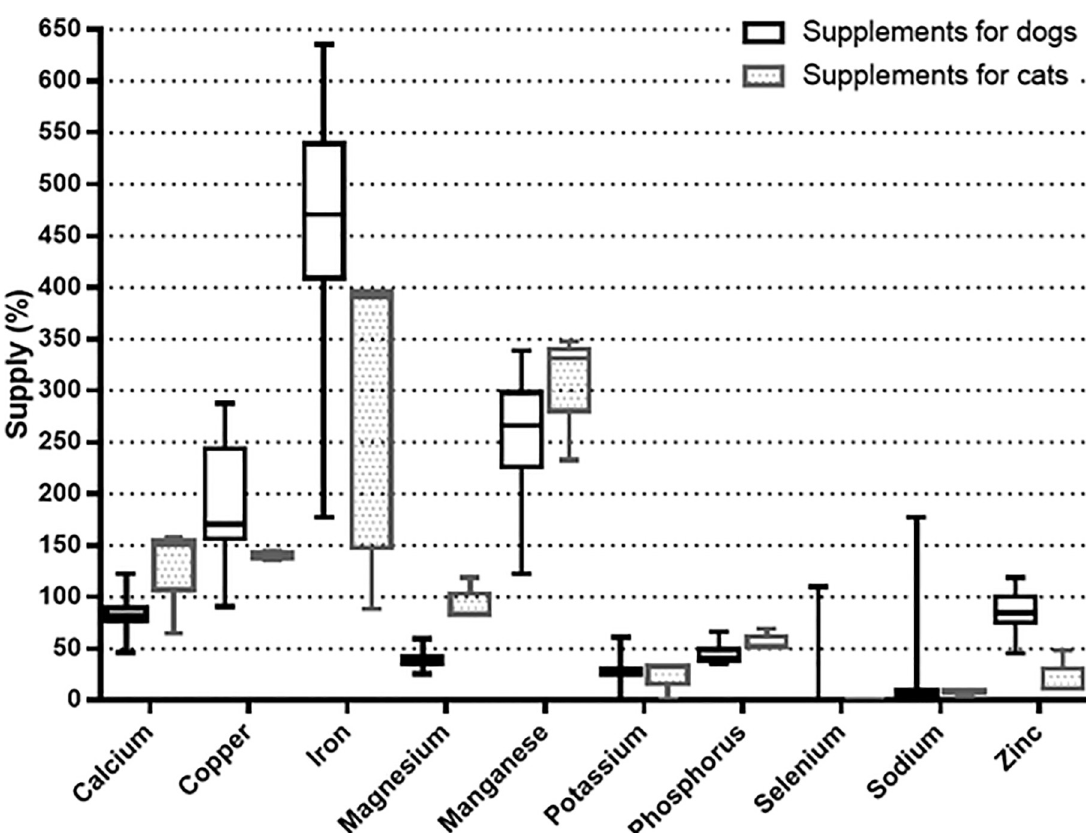
Fig 2. Box-and-whiskers plot of the percentages of mineral supply of the analyzed supplements according to the recommendations of FEDIAF (2020) in mg/kg of metabolic weight (BW 0.75 for dogs and BW 0.67 for cats).